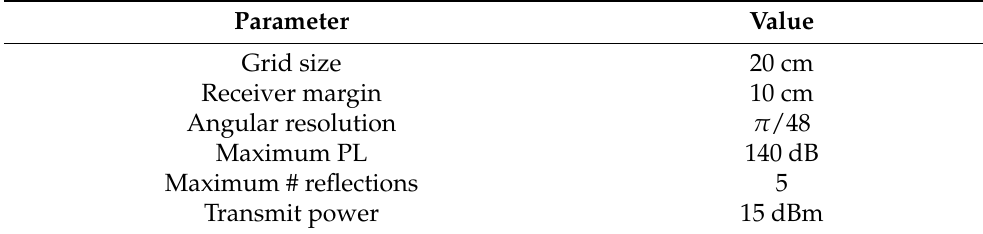
Table 2. Simulation parameters coverage prediction tool.